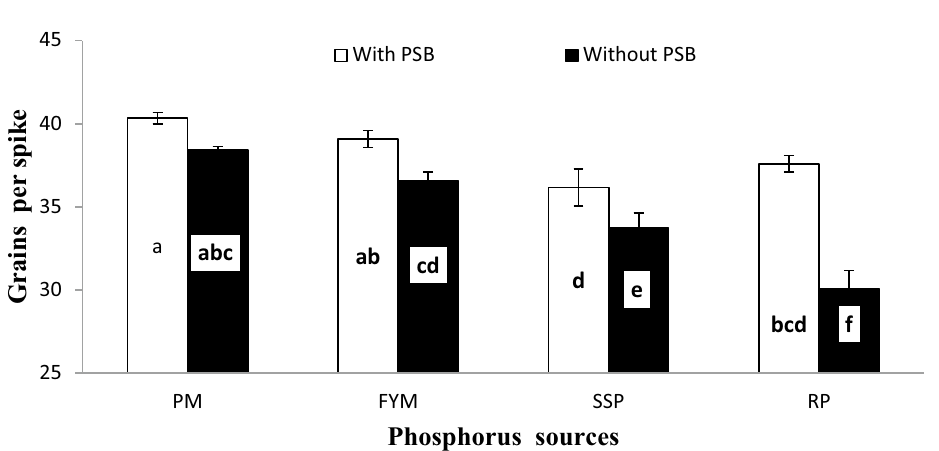
Figure 5. Interactive effect of P sources and PSB on wheat grains per spike. Graph bars having different letters are significantly different at α = 0.05. Errors bar represent standard error for the mean of three